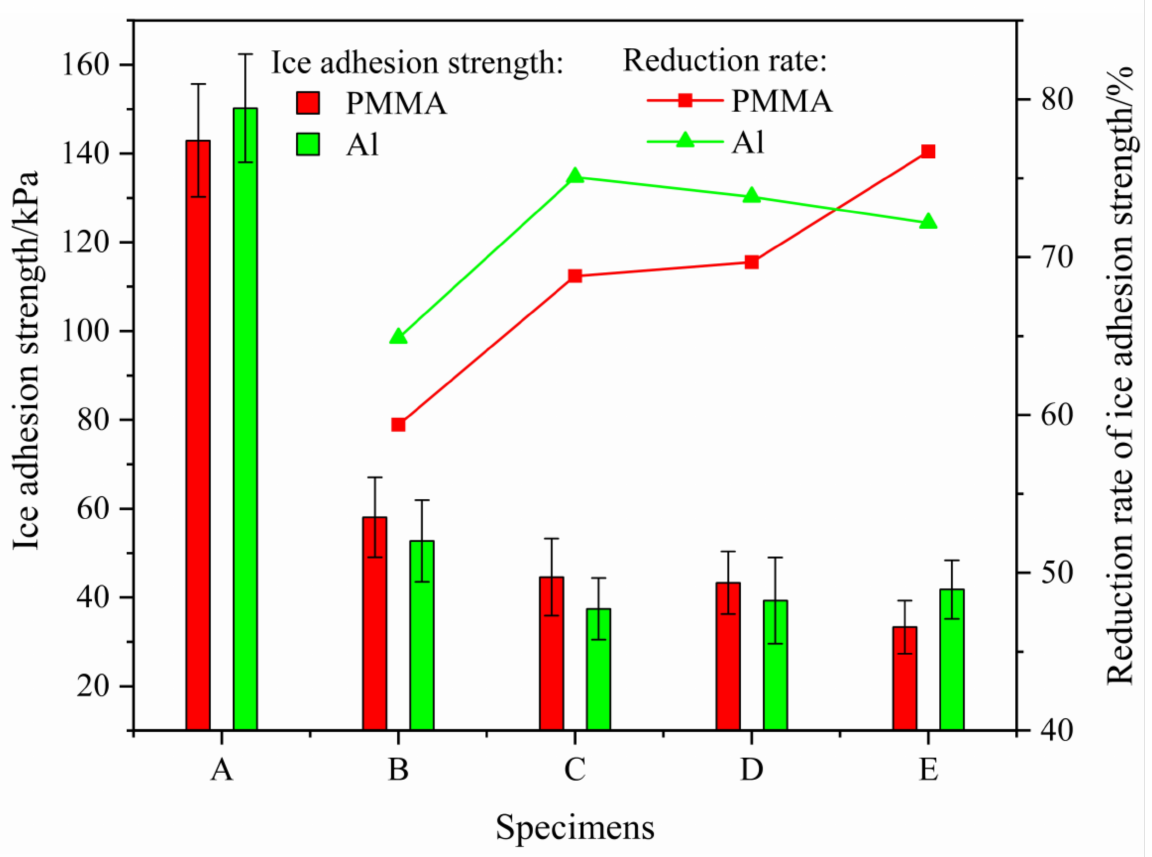
Figure 9. Shear ice adhesion